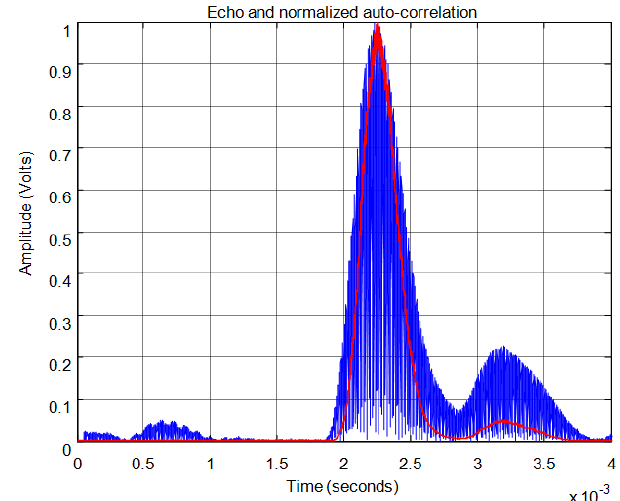
Figure 23. Normalized echo and auto-correlation for an echo formed by two overlapping